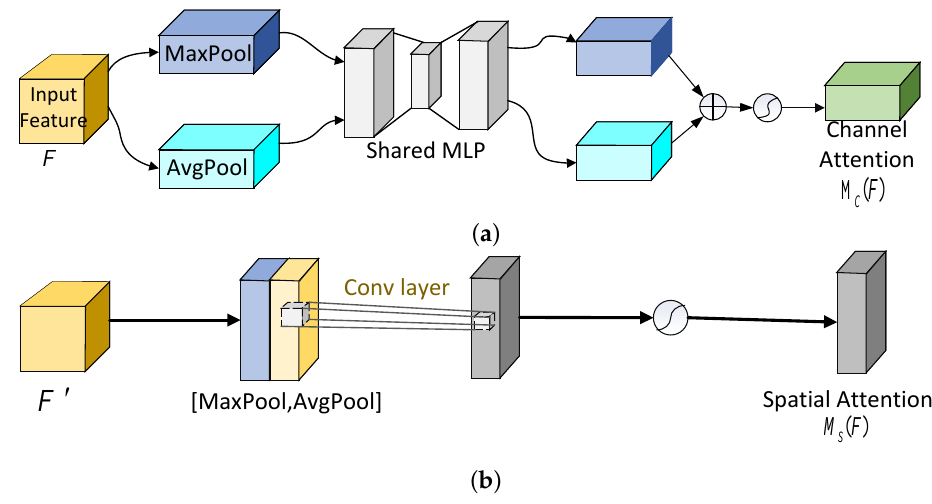
Figure 4. CBAM channel, spatial attention module.